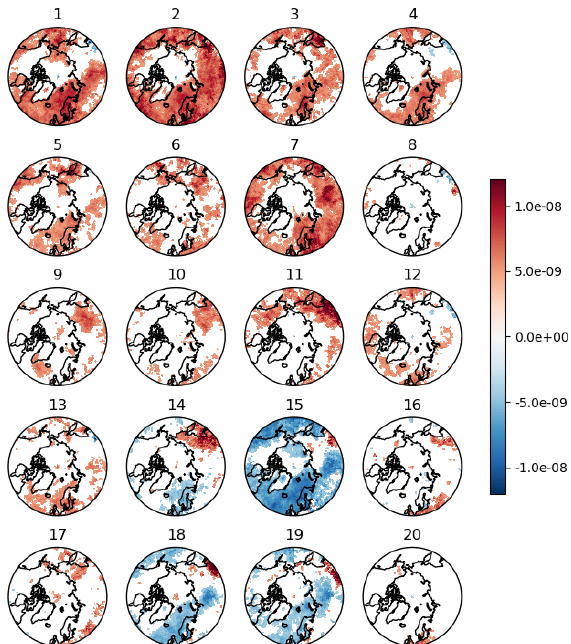
Figure A7. The 500hPa CO anomalies as volume mixing ratios based on AIRS data for the 20 circulation types. Only those anomalies that are statistically significant at the 90% confidence level are